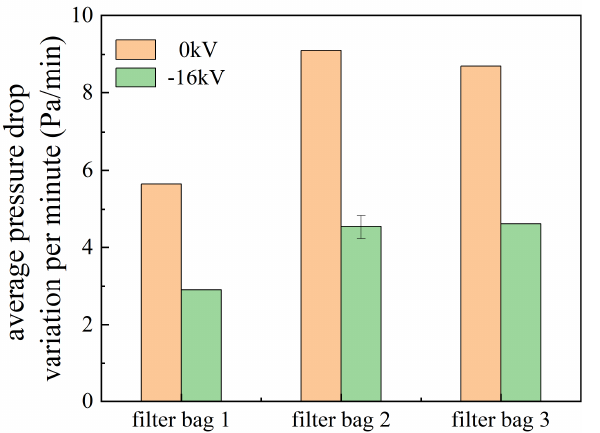
Figure 8. Dust collectors’ average pressure drop variation per minute with different filter bags.